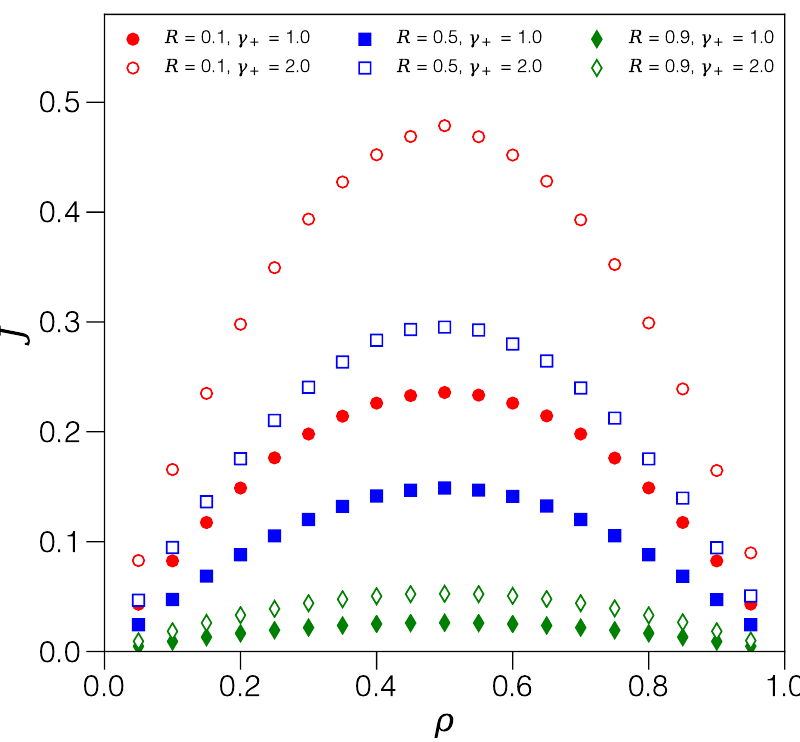
Figure 3: Current J as a function of the particle density ρ for different values of the parameters R and γ +